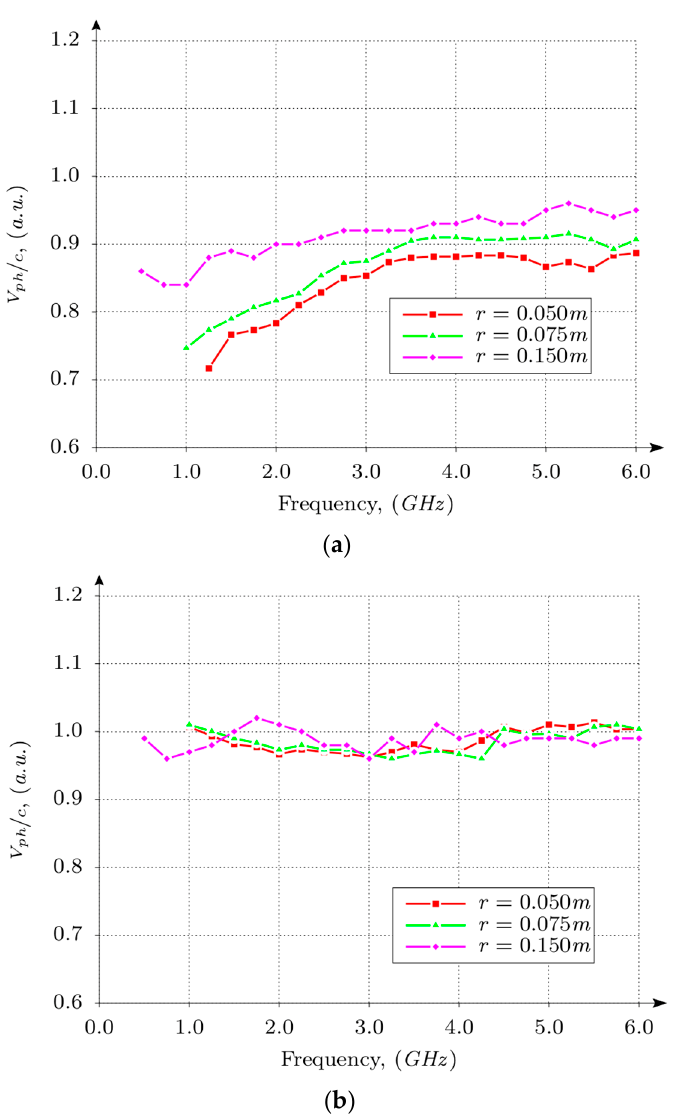
Figure 15. The distribution of the electric field component of the EM waves propagating along the surface at the frequency f = 2.45 GHz: the creeping wave ( a ); the surface wave ( b ). The frequency dependence of the phase velocity normalized to the speed of light in the free space for a set of different shoulder radius r is presented in Figure 16.